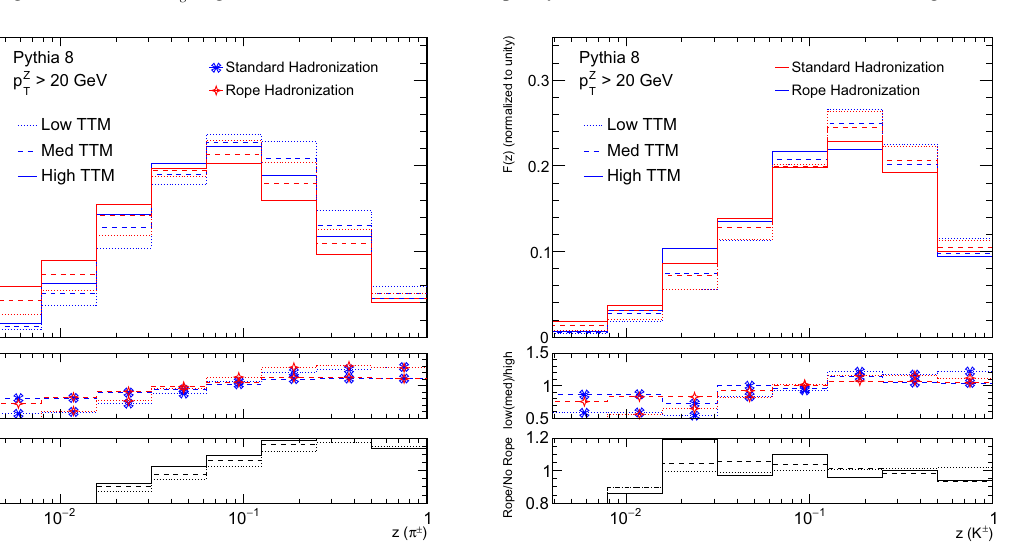
Fig. 14 Thedistributionofthemomentumfraction( z )carriedbypions (left) and kaons (right) for low ( < 50), medium (50 < TTM < 100), and high ( > 100) TTM for both the default and Rope hadronization models. The middle panel shows the ratio of the distributions for high